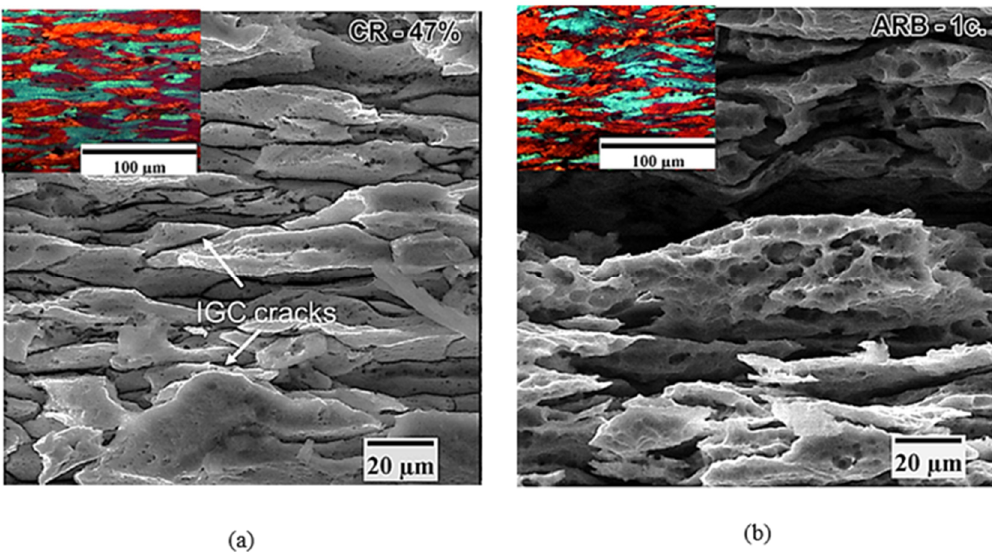
Figure 12. Cross-section surface morphology of ( a ) CR AA5083 alloy, and ( b ) ARB AA50083 alloy after sensitization for 7 days at 150 °C. (The insets in the figures show the grain structure after processing). Adapted from Ref. [83].